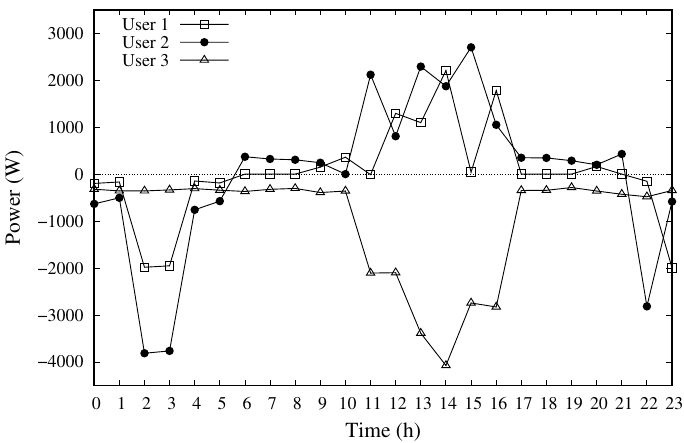
Figure 4. Daily profile of the three users with the Unified model.